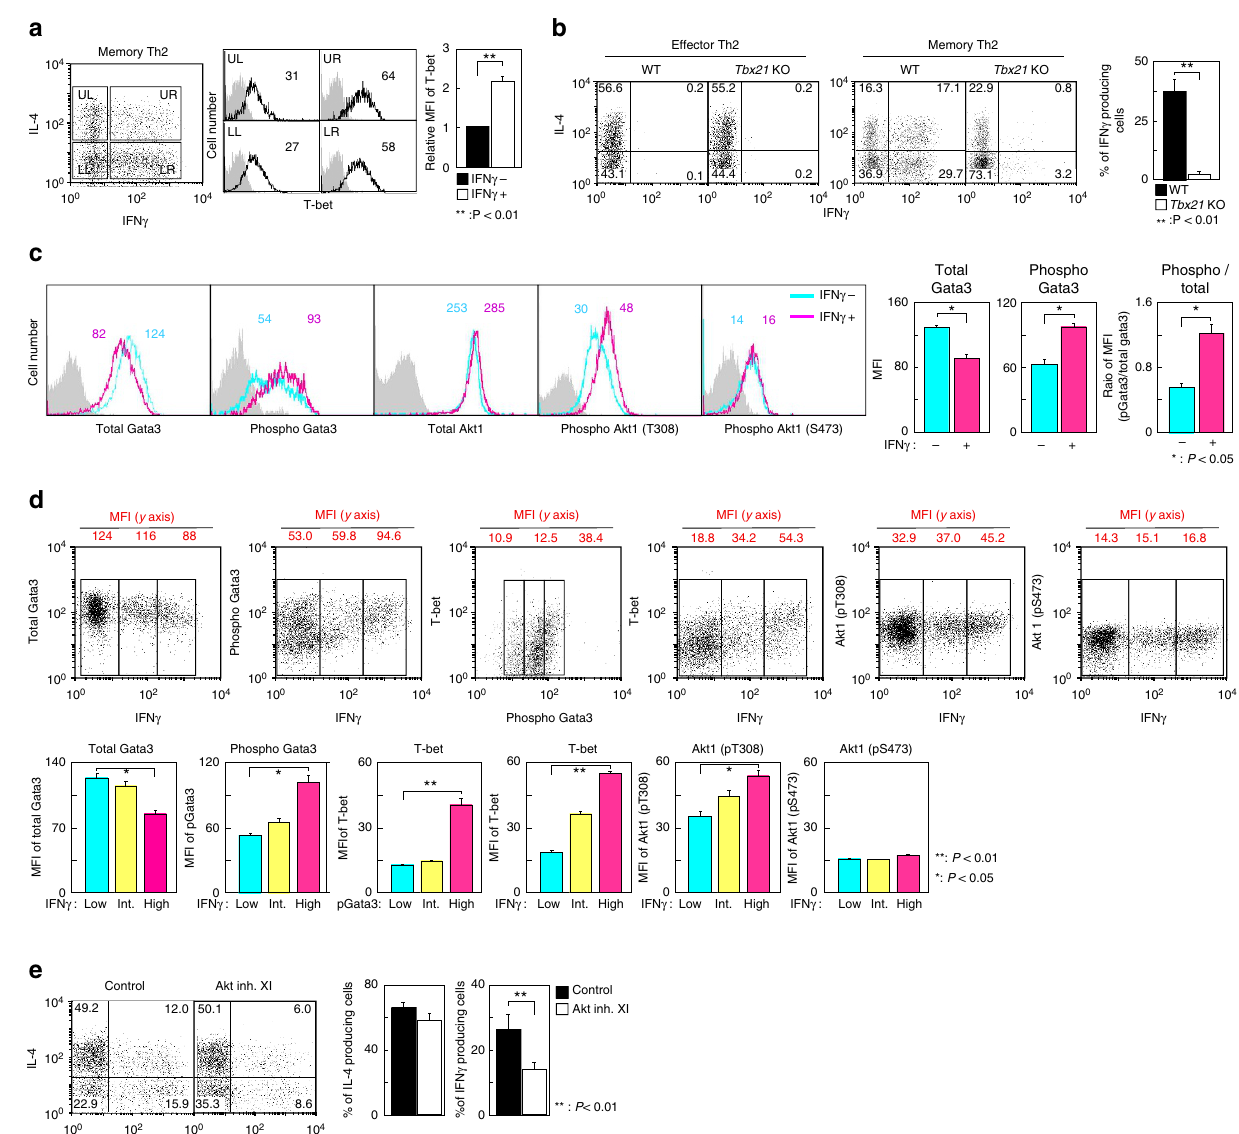
Figure 6 | Increased phosphorylation status of Gata3 and Akt1 in IFN c -producing memory Th2 cells. ( a ) Memory Th2 cells were stimulated with PMA plus ionomycin for 6h. The cells were divided into four distinct subpopulations according to their expression of IL-4 and IFN g (left). Intracellular staining profiles of T-bet in these four subpopulations are shown (middle). The number in the histogram represents the MFI. The grey-filled histogram shows isotype control staining. A summary of the MFI of T-bet in IFN g -producing and -nonproducing cells is presented (right) ( n ¼ 5). ( b ) Intracellular staining profiles of IFN g and IL-4 in effector and memory Th2 cells from WT or Tbx21 -deficient mice are shown with the percentages of cells in each area (left). A summary of the percentage of IFN g -producing memory Th2 cells is presented (right) ( n ¼ 3). ( c ) Intracellular staining profiles of Gata3, phospho-Gata3, Akt1 and phospho-Akt1 in IFN g -producing and -nonproducing memory Th2 cells are shown (left). A summary of the MFI value of Gata3 and phospho- Gata3 and the ratio of the MFI (phospho-Gata3/total Gata3) in IFN g -producing and IFN g -nonproducing memory Th2 cells is presented (right) ( n ¼ 5). ( d ) Intracellular staining profiles of IFN g , Gata3, phospho-Gata3, T-bet and phospo-Akt1 are shown. The number represents the MFI of the y axis in each area (top). A summary of the MFI in each area (IFN g : Low, Int, High) is presented (bottom) ( n ¼ 5). ( e ) Memory Th2 cells were cultured in IL-7-containing medium with or without Akt inhibitor XI (10 m M) for 2 days. Intracellular staining profiles of IFN g and IL-4 are shown (left). A summary of the percentage of IL-4- and IFN g -producing memory Th2 cells is presented (right) ( n ¼ 4). ** P o 0.01, * P o 0.05 by Student’s t -test. Five ( a ), four ( e ) and three ( b , c , d ) independent experiments were performed with similar